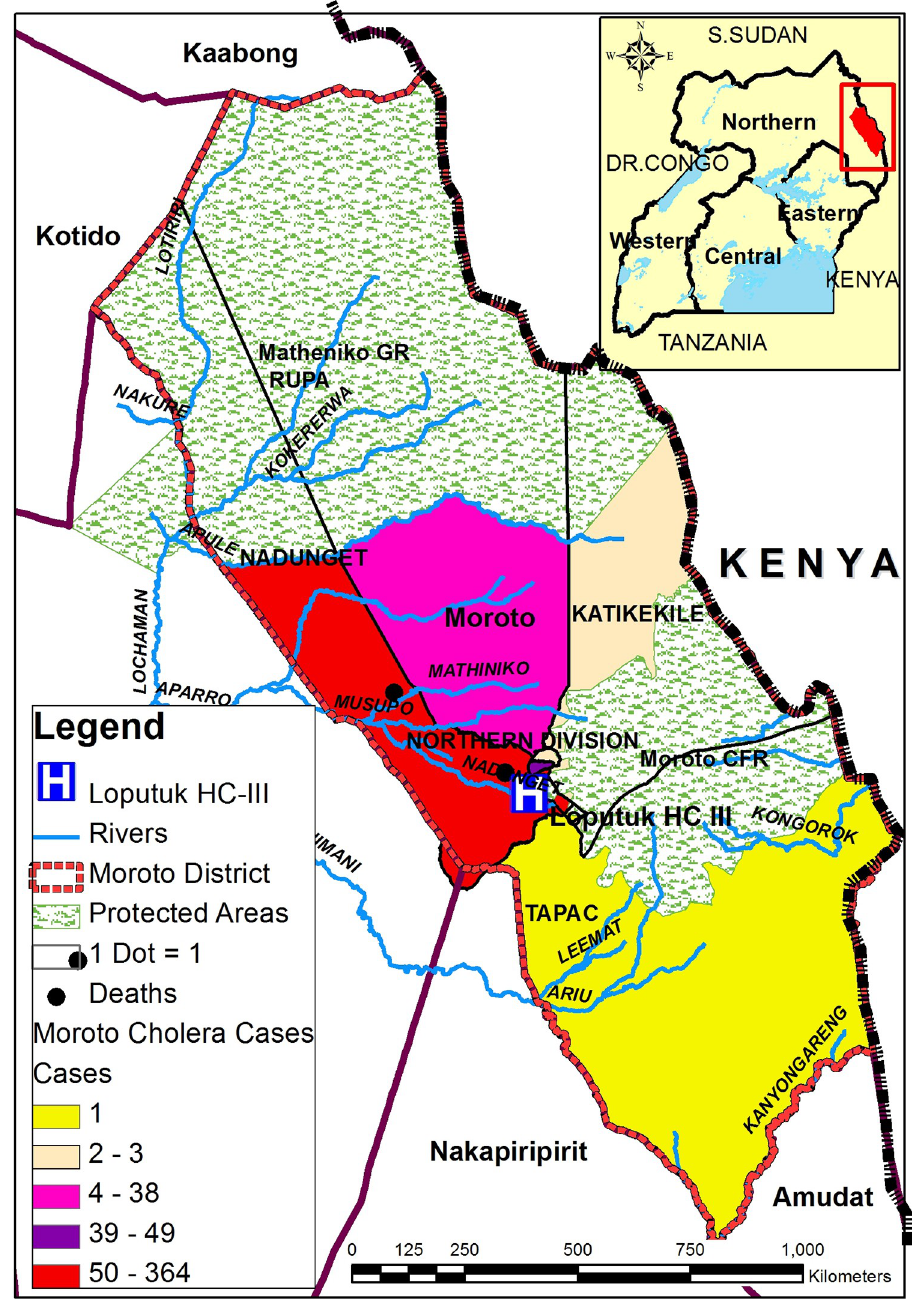
Fig 1. Map of Moroto district showing the cholera affected sub-counties and the location of Moroto district on the map of Uganda. The cholera affected sub-counties are in bright colors with each of the colors representing different number of reported cholera cases. Each of black dot represent 1 death. The shapefiles used to generate the map were from open access, the Humanitarian Data Exchange at https://data.humdata.org/.